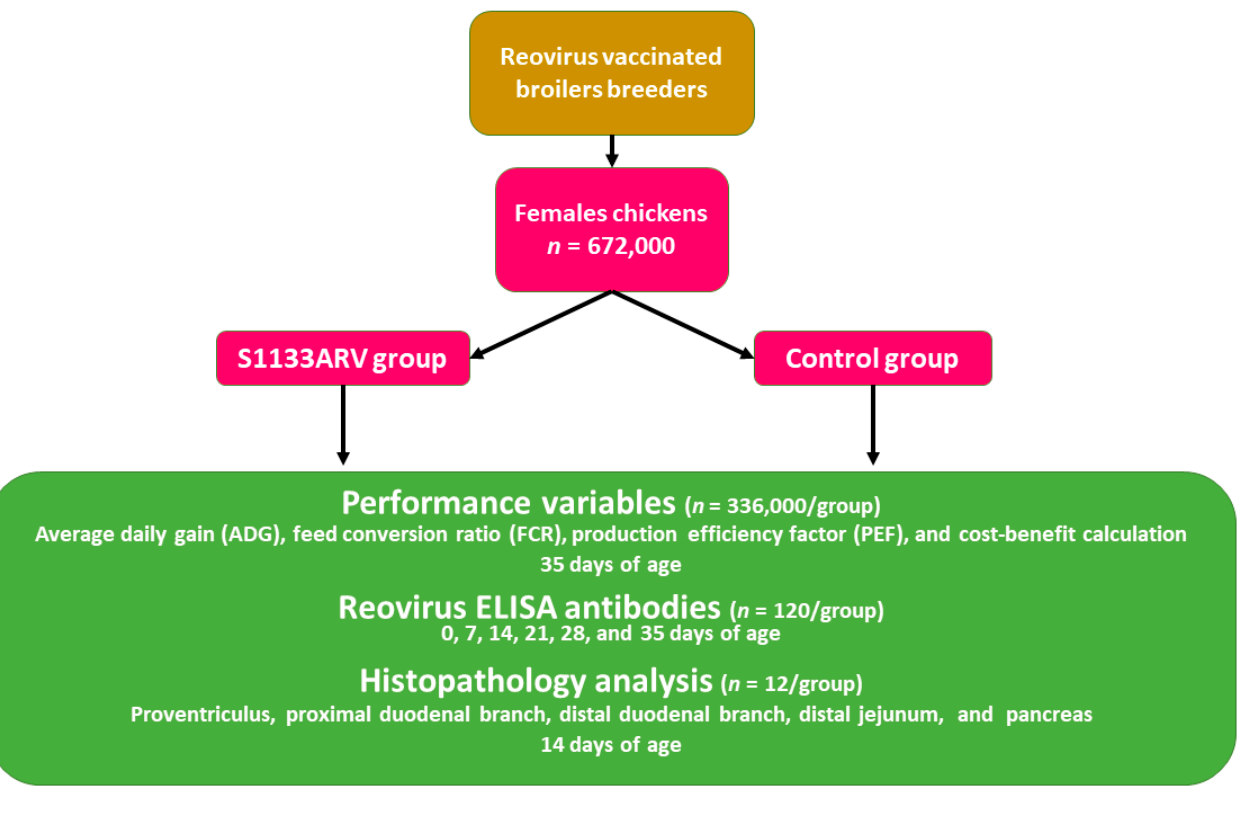
Figure 1. Twenty-four chicken houses with a capacity of 28,000 female broiler chickens were selected from a commercial company ( n = 672,000 total chickens). Twelve houses were randomly selected, and chickens were vaccinated at 1-day-old using a spray cabinet with the avian reovirus S1133 strain, whereas the other 12 houses served as the nonvaccinated control group. The variables evaluated were productive performance, reovirus ELISA antibodies, and histopathology analysis.